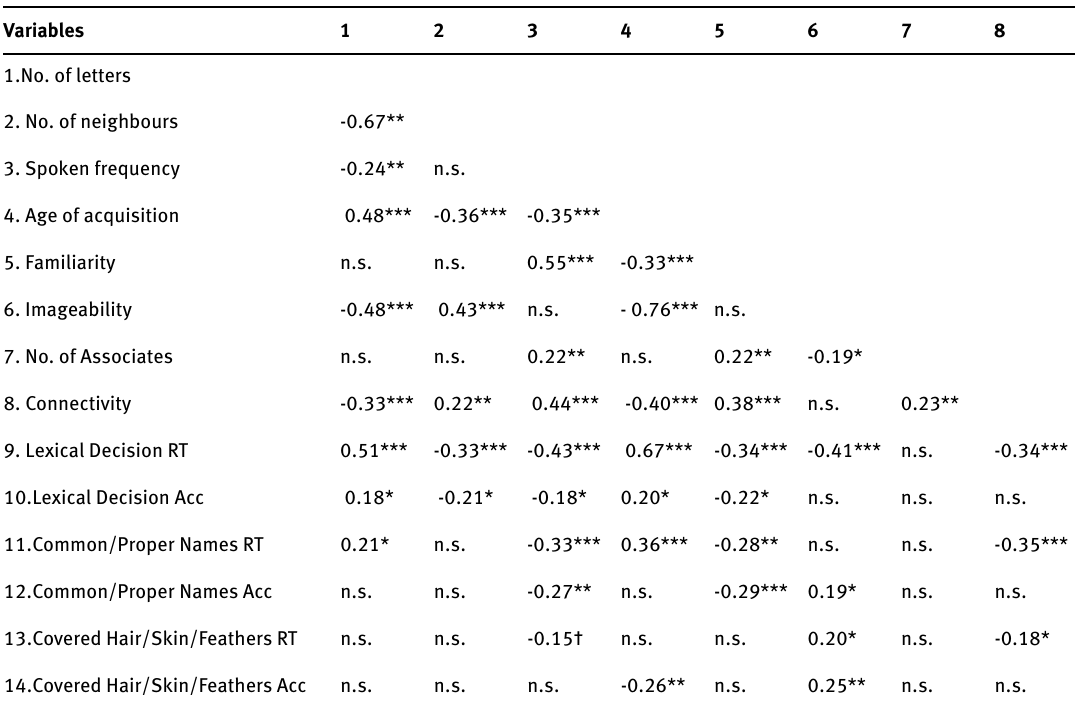
Table 2: Correlation matrix for the predictor and dependent variables in the lexical decision and categorization tasks